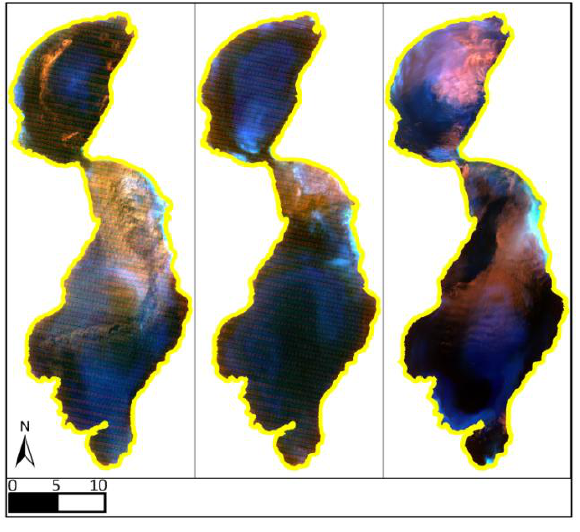
Figure 4 . Egirdir Lake areas and shorelines (yellow polygons) for the years 1998, 2008 and 2018, respectively, from left to